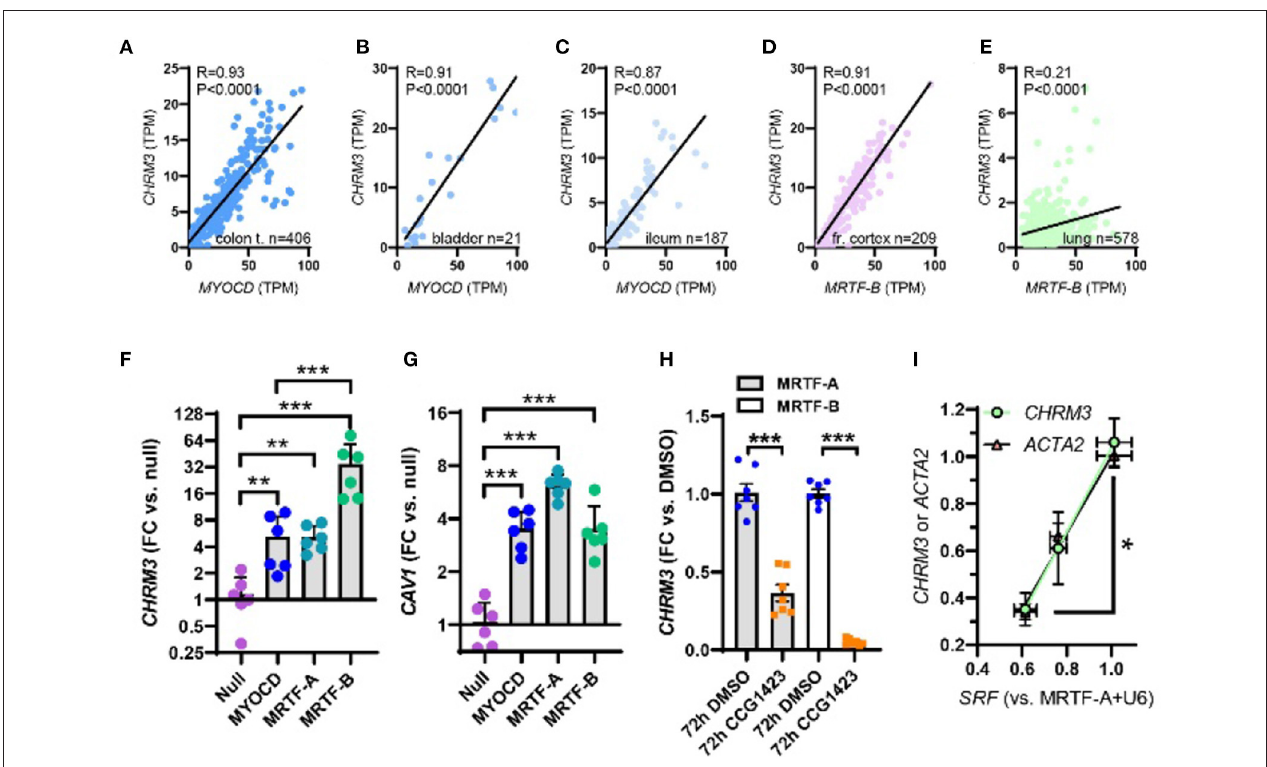
FIGURE 2 | Myocardin (MYOCD) correlates with the M3 muscarinic receptor ( CHRM3 ) across human tissues and SRF is critical for CHRM3 regulation by MRTFs. (A) through (C) show correlations at the mRNA level of MYOCD vs. M3 ( CHRM3 ) in the human gastrointestinal tract and urinary bladder. In brain (D) and lung (E) , MRTFB , rather than MYOCD , correlated with M3. This prompted us to examine if all MRTFs (MYOCD, MRTF-A, and MRTF-B) regulate M3 at the mRNA level. Viral overexpression in human coronary artery SMCs showed that MRTF-B was a more effective transactivator of CHRM3 than MYOCD [ (F) , n = 6], despite having the same effect as MYOCD on another target [ CAV1 , (G) ]. (H) Shows reduction of CHRM3 after treatment for 72h with the MRTF-SRF inhibitor CCG-1423 (10 µ M, n = 6). Cells were transduced with either MRTF-A (gray bars) or MRTF-B (white bars). (I) Shows that knockdown of serum response factor (SRF, 0, 30, and 100 MOI of Ad-shSRF) reduces CHRM3 (green/black circles) in parallel with ACTA2 (pink/black triangles, n = 4, per condition). MRTF-A was overexpressed throughout in (I) . *** p < 0.001, ** p < 0.01, and * p <